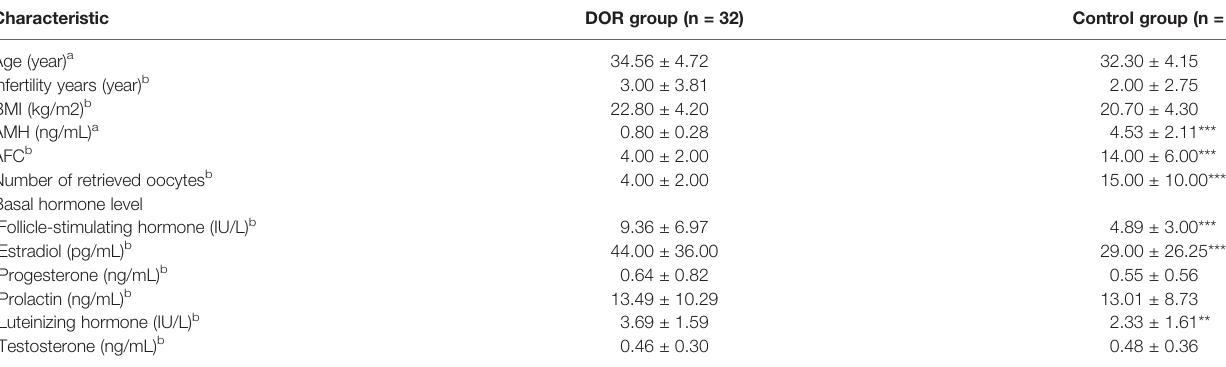
TABLE 2 | Characteristics of diminished ovarian response (DOR) patients and controls.